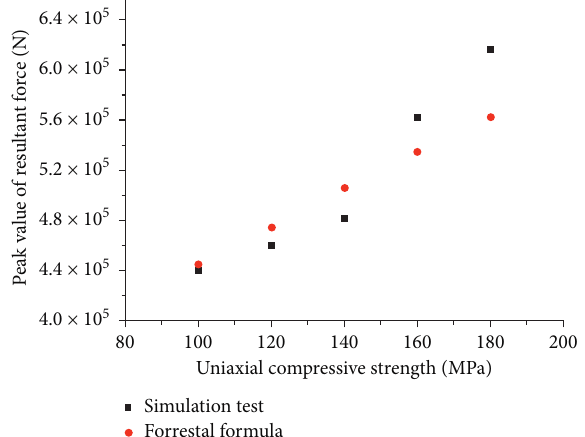
Figure 9: Peak value of resultant force between the simulation test and the Forrestal